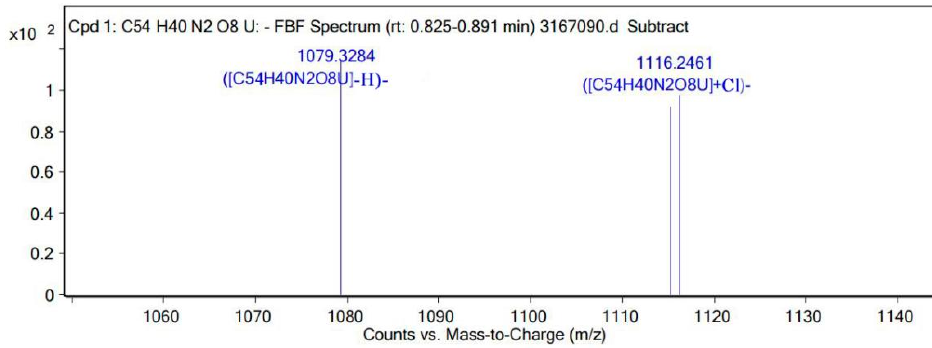
Figure 13. High-resolution mass spectrum of (HTPAF) 2 -UO 2 complex.